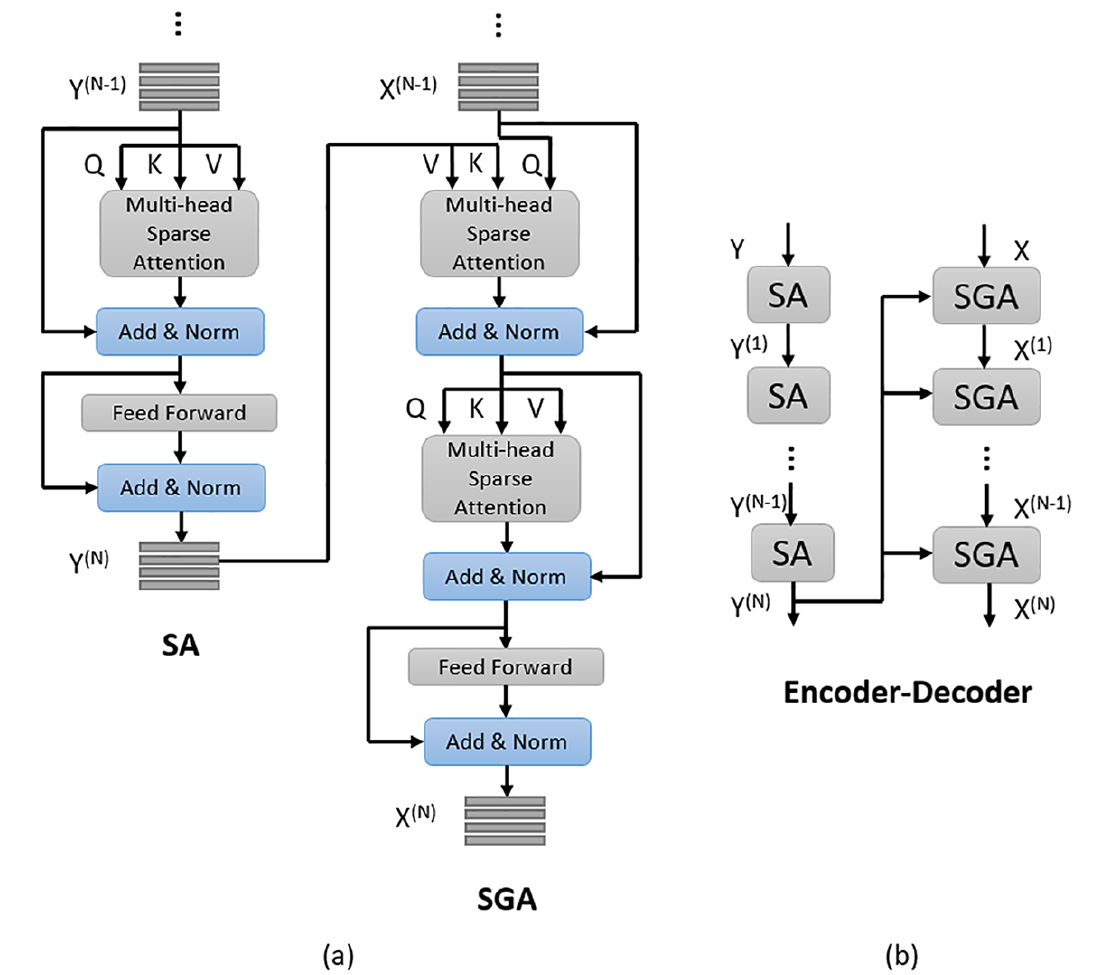
Figure 3. ( a ) The details of SA (slef-attention) and SGA (self&guided-attention) units. ( b ) The structure of the encoder-decoder